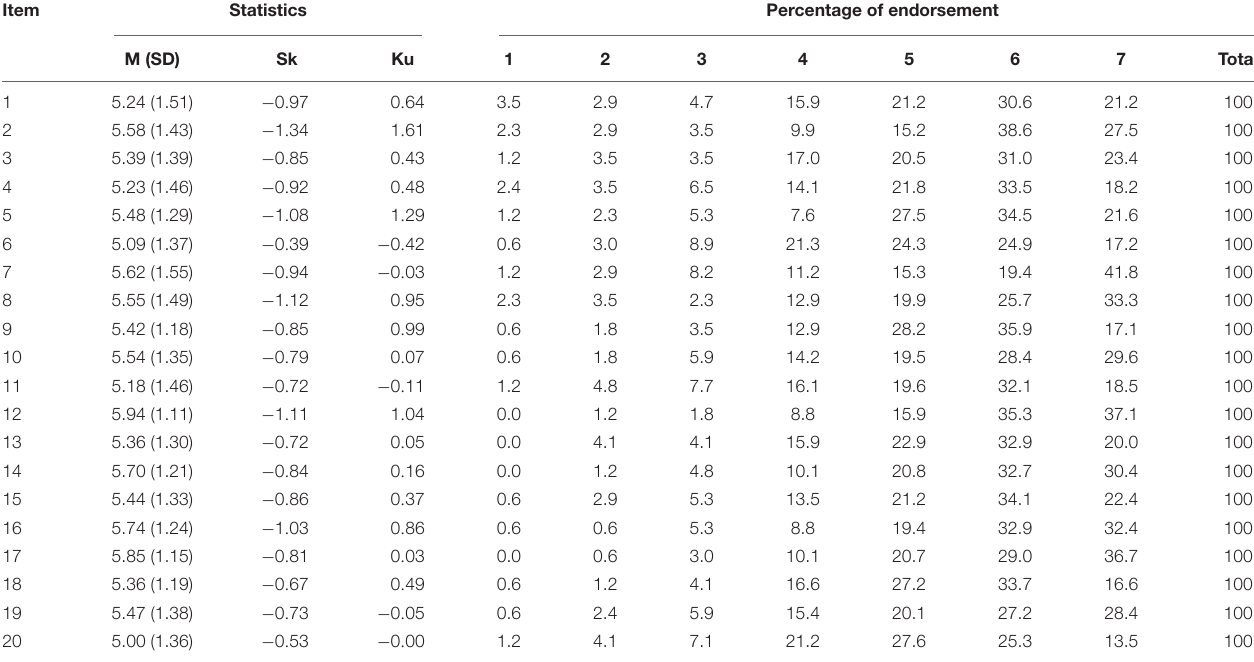
TABLE 2 | Individual PACT item summaries for the total